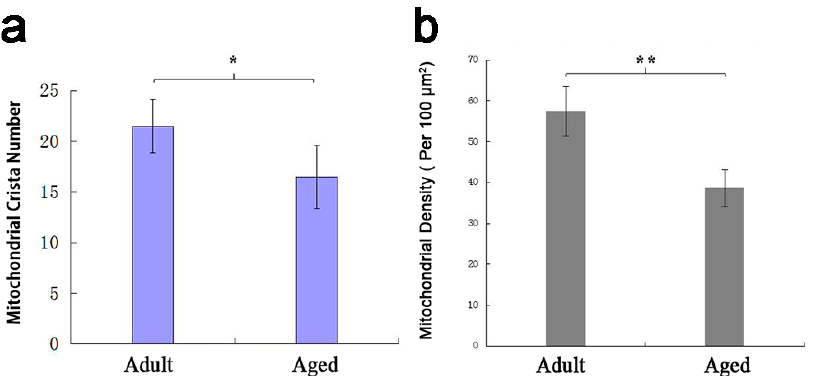
Figure 4. The number of mitochondrial crista ( a ) and density of mitochondria ( b ) in the myocardium of adult and aged Tibetan Sheep. Data show means ± SD. * p < 0.05, ** p < 0.01.